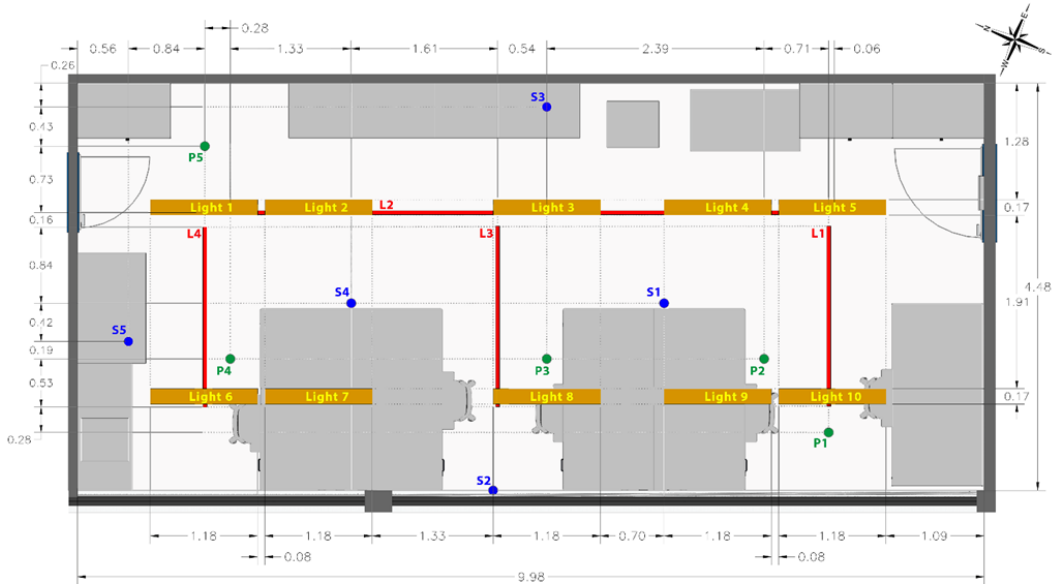
Figure A2. Room 2 (R2) floor plan with test points (P1 – P5) and test lines (L1 – L4) for the performance of physical activities and spectrum test points (S1 – S5).